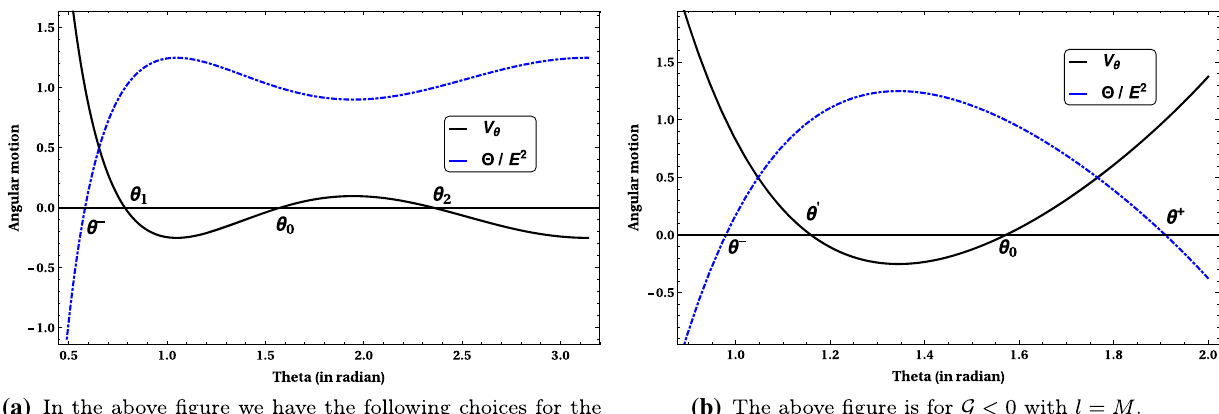
Fig. 9 The angular motion of a particle in Kerr–Newman-NUT spacetime has been presented with a non-zero Carter constant λ = M 2 , having the impact parameter L / E = ξ = 0 . 5 M and the rotation parameter set to black hole mass θ = π/ 2. The motion is depicted in Fig. 8 for a 0 particular set of